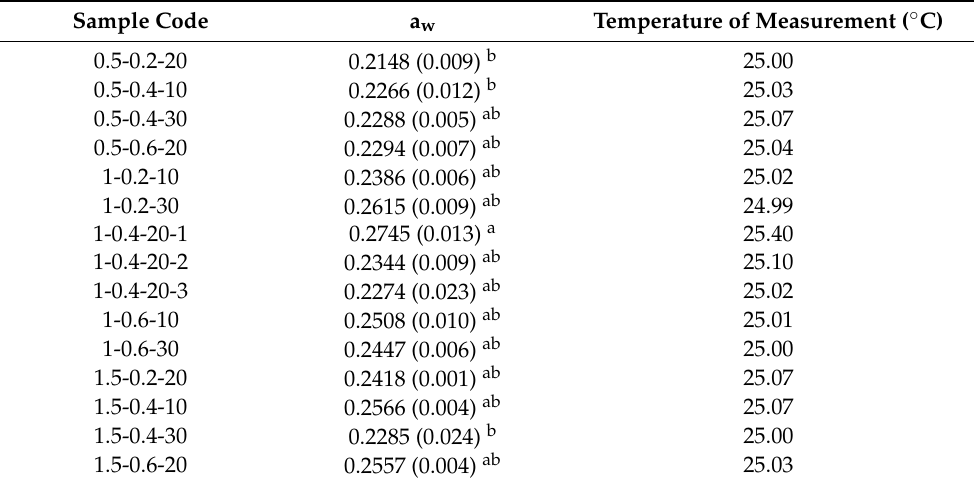
Sample Code a w Temperature of Measurement ( ◦